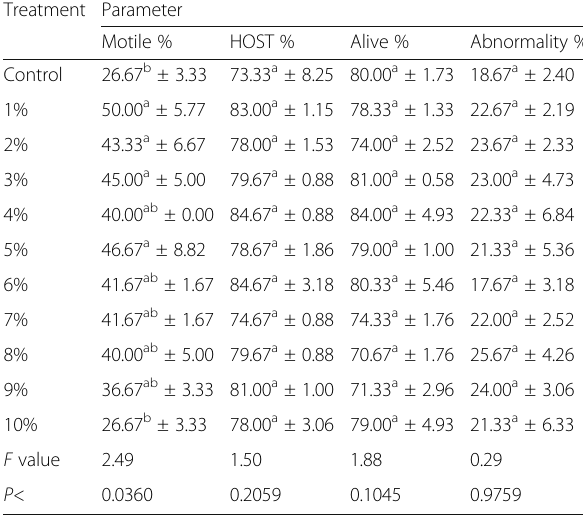
Mean ± S.E. Different letter superscripts indicate a significant difference between means within column using the multiple range Duncan ’ s test at P < 0.05